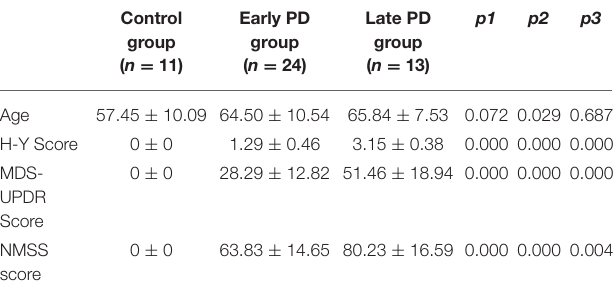
TABLE 1 | Demographics and clinical characteristics of the PD